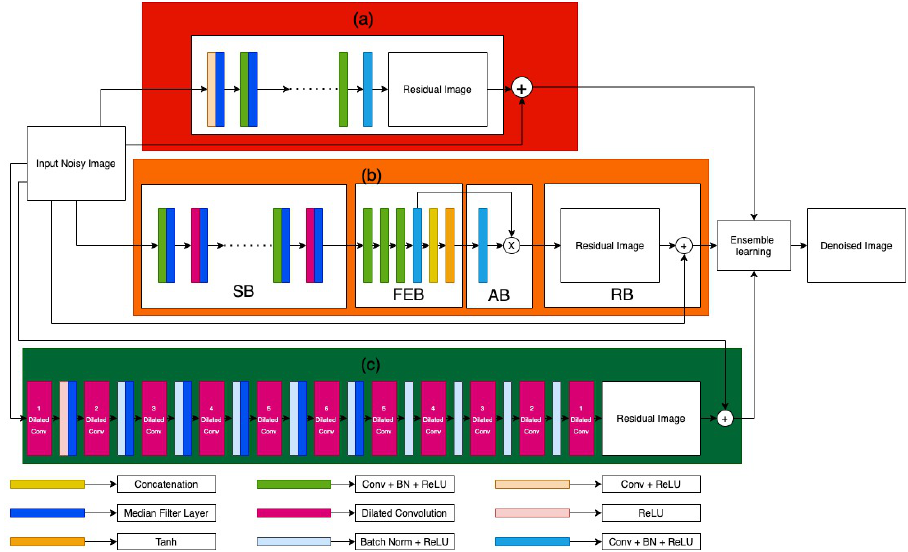
Figure 1. Our proposed ensemble image denoising model. In the figure ( a ) denotes the improved Denoising CNNs (DnCNN) model, ( b ) represents the improved ADNet model, and ( c ) denotes the improved IRCNN